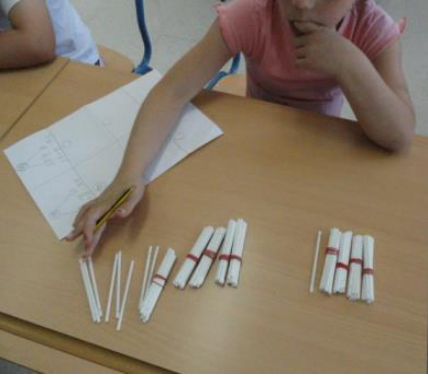
Figure 5. Flexible breakdown.